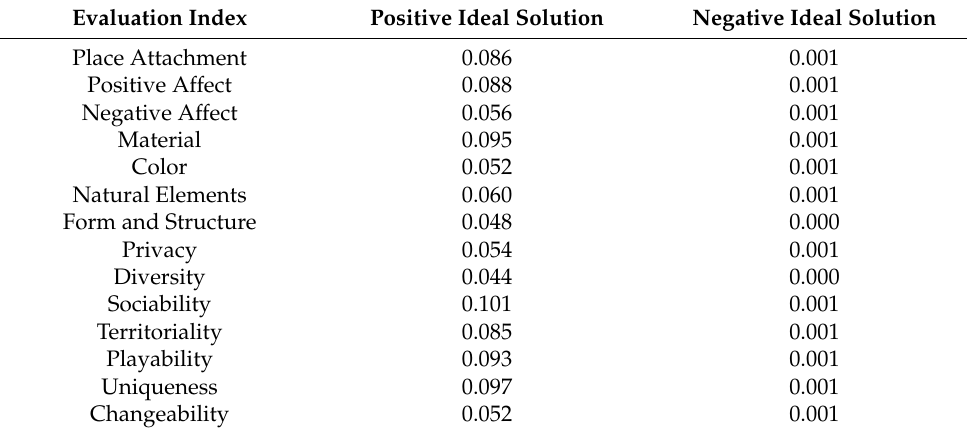
Table 9. Positive ideal solution and negative ideal solution of each indicator.